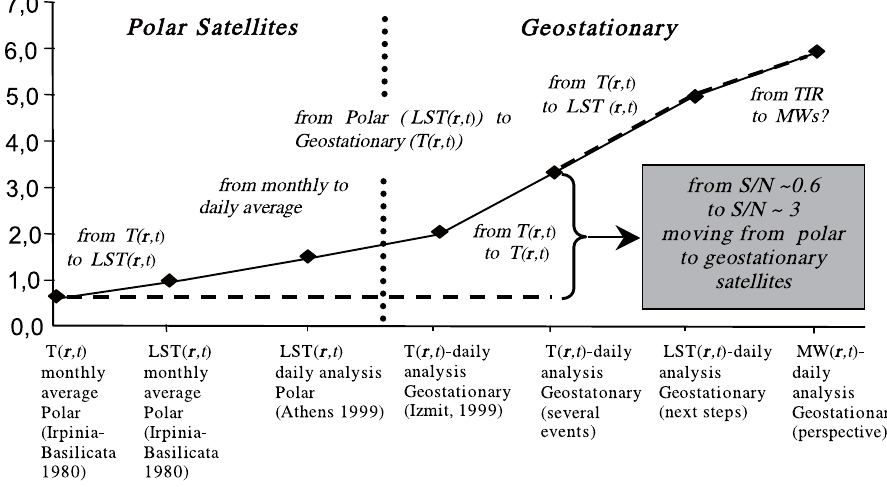
Fig. 1. S/N evolution after the application of the RST approach to different satellite sensors and different AL- ICE